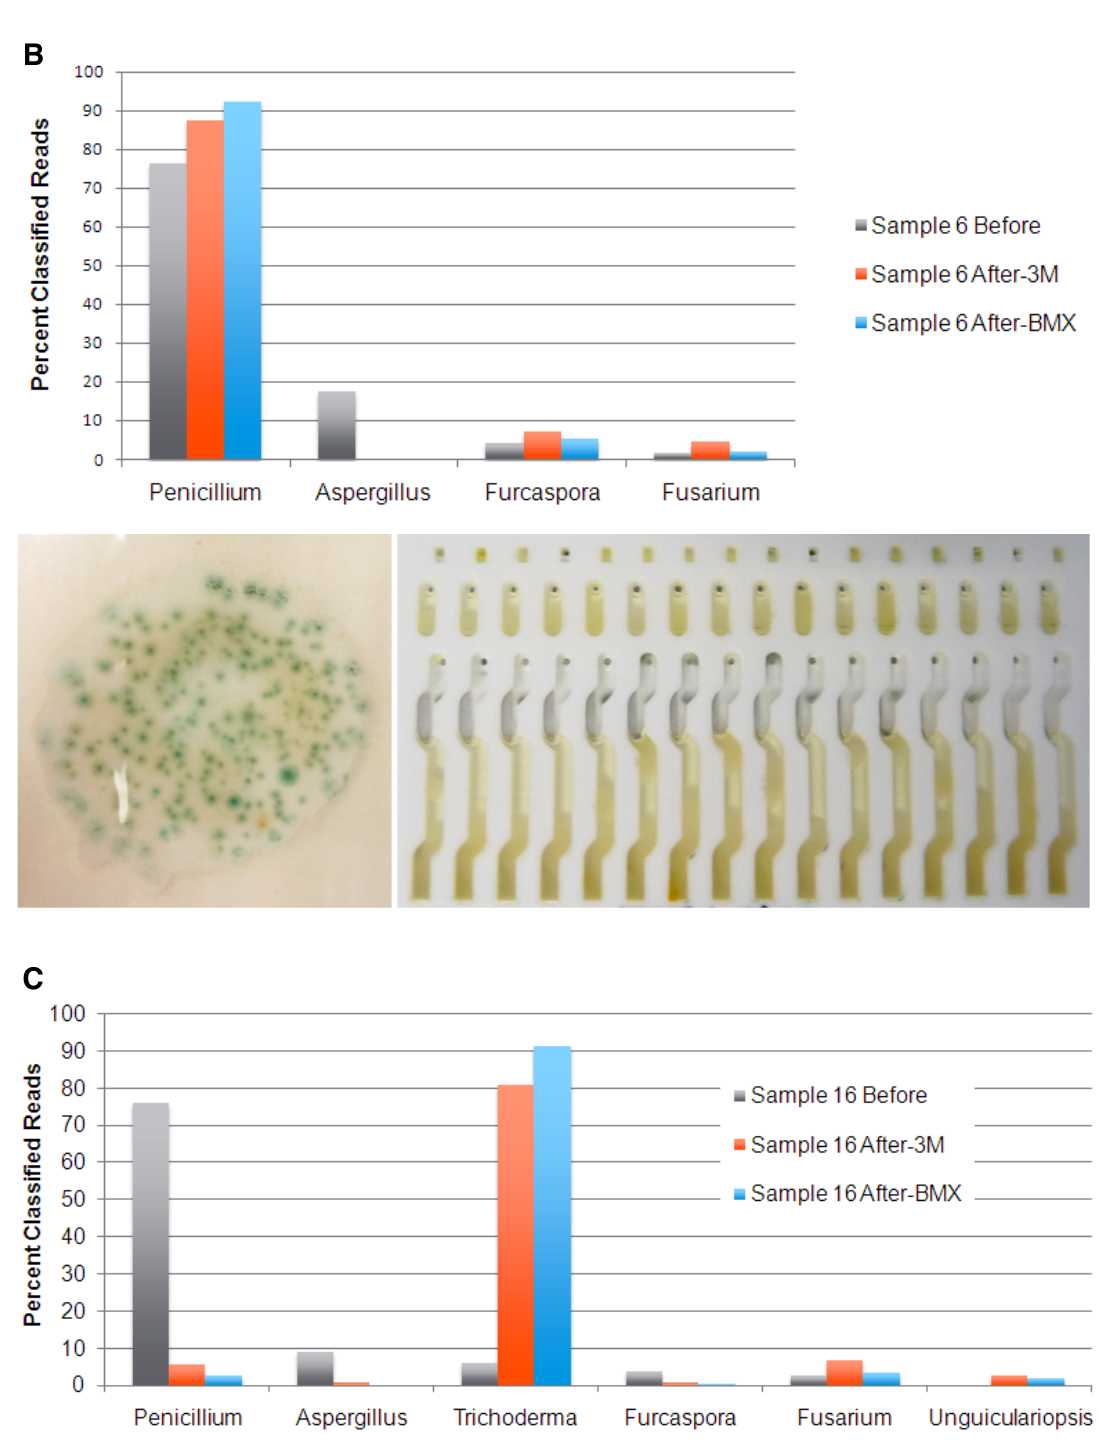
Figure 2. A) TYM platform discordance before and after growth. Results from sample 4 showing the percentage of reads classified into fungal genera based on sequencing of TYM ITS2 amplicons directly from the plant (Before), or after growth on the 3M or BMX platforms. The lower part of the figure shows the colonies observed on 3M media (left) and appearance of the BMX YM card (right) after growth. B) Poor growth of Aspergillus species. In 12/15 cases where Aspergillus species are detected by ITS2 sequencing, they do not grow on 3M or BMX media (results from sample 6). The lower part of the figure shows the colonies observed on 3M media (left) and appearance of the BMX YM card (right) after growth. C) Trichoderma antagonism. Penicillium species are present in material extracted directly from the plant in sample 16, but are displaced by Trichoderma after growth on 3M or BMX